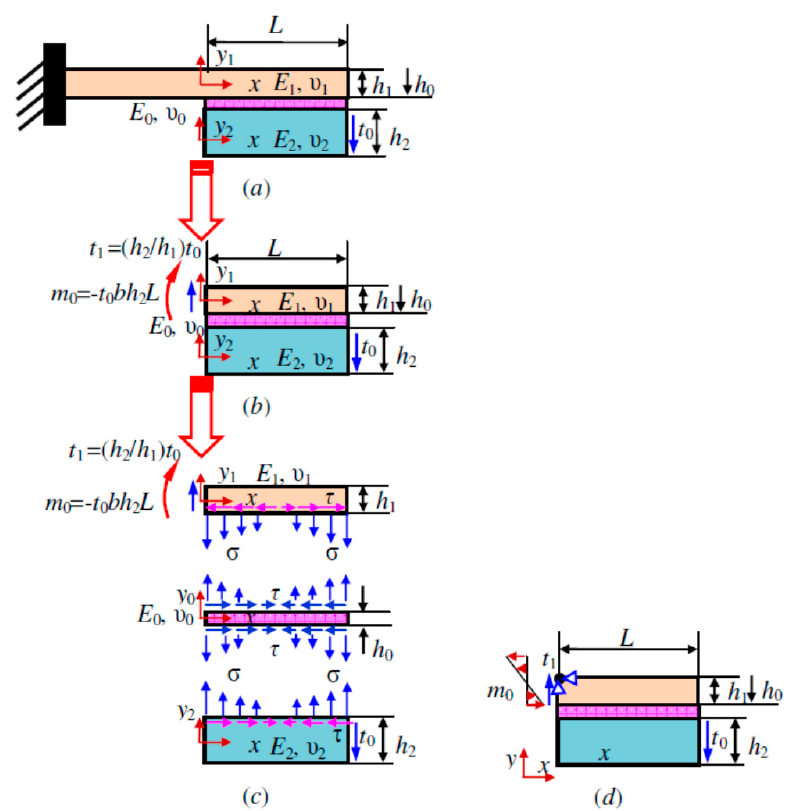
Figure 3. ( a ) Schematic of an adhesively bonded single-lap joint (ABSLJ) under shearing; ( b ) the slender upper adherend layer, the adhesive layer, and the slender lower adherend layer; ( c ) interfacial stress distribution in the joint; ( d ) joint segment used in finite element modeling.